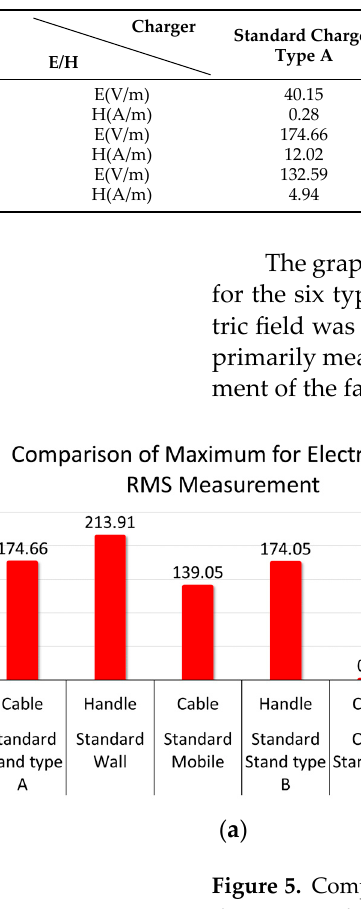
Table 4. Comparison of maximum RMS measurement values of 6 types of wired chargers.